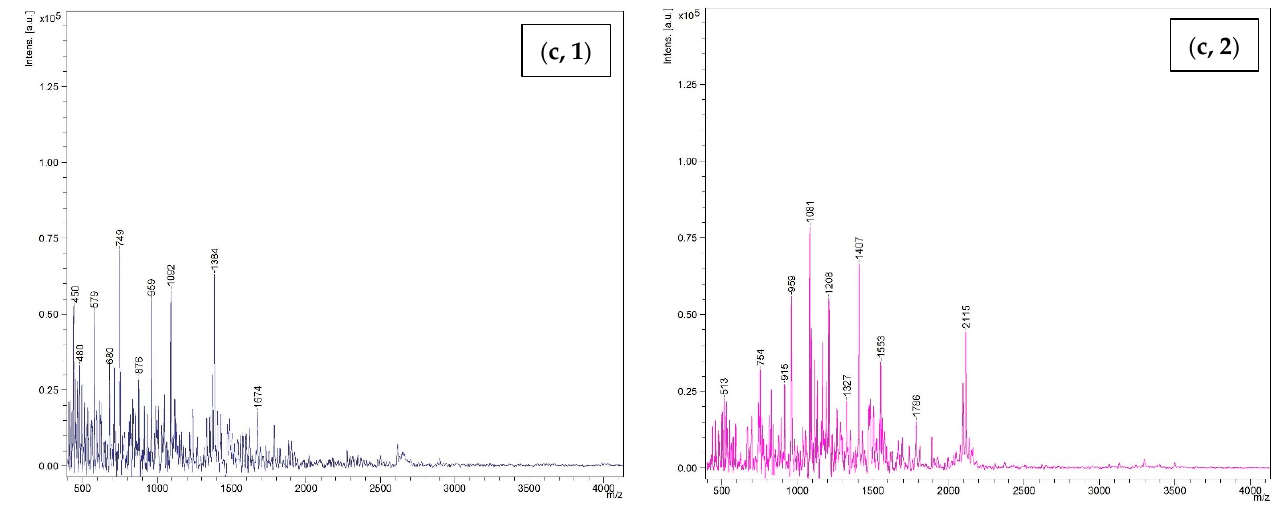
Figure 7. Size distribution of hydrolyzed proteins including ( a ) whey protein isolate; ( b ) kidney bean protein isolate; ( c ) threadfin bream fish mince using commercial pepsin ( 1 ) and tuna pepsin ( 2 ) at a level of 15 units/g protein.